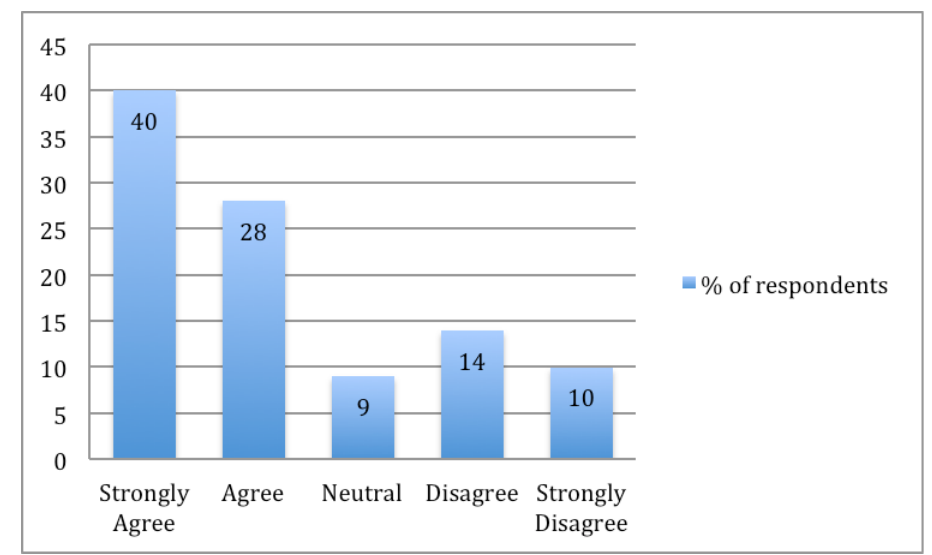
Figure 1. Lack of access to computers and the Internet. Low Internet bandwidth.